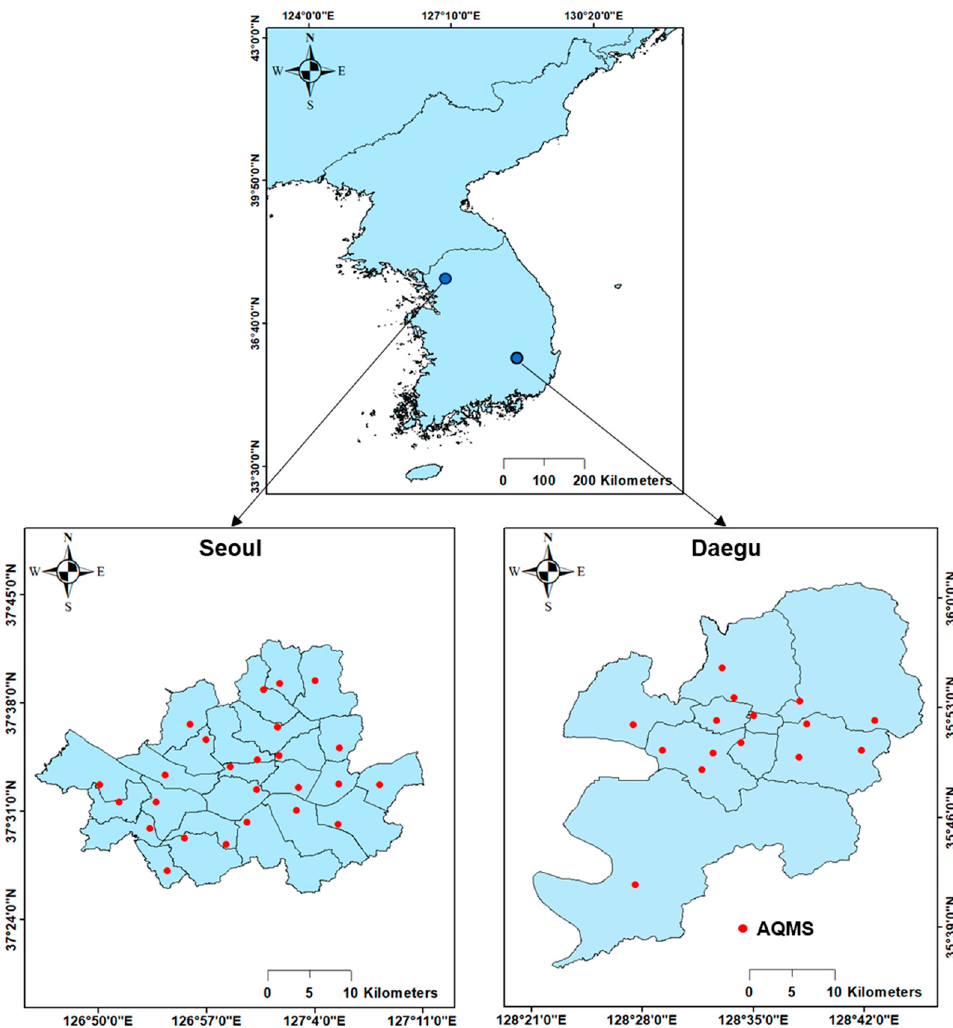
Figure 2. Location of Seoul (left) and Daegu (right) in Korea. Red dots indicate the location of the air quality monitoring stations (AQMS).